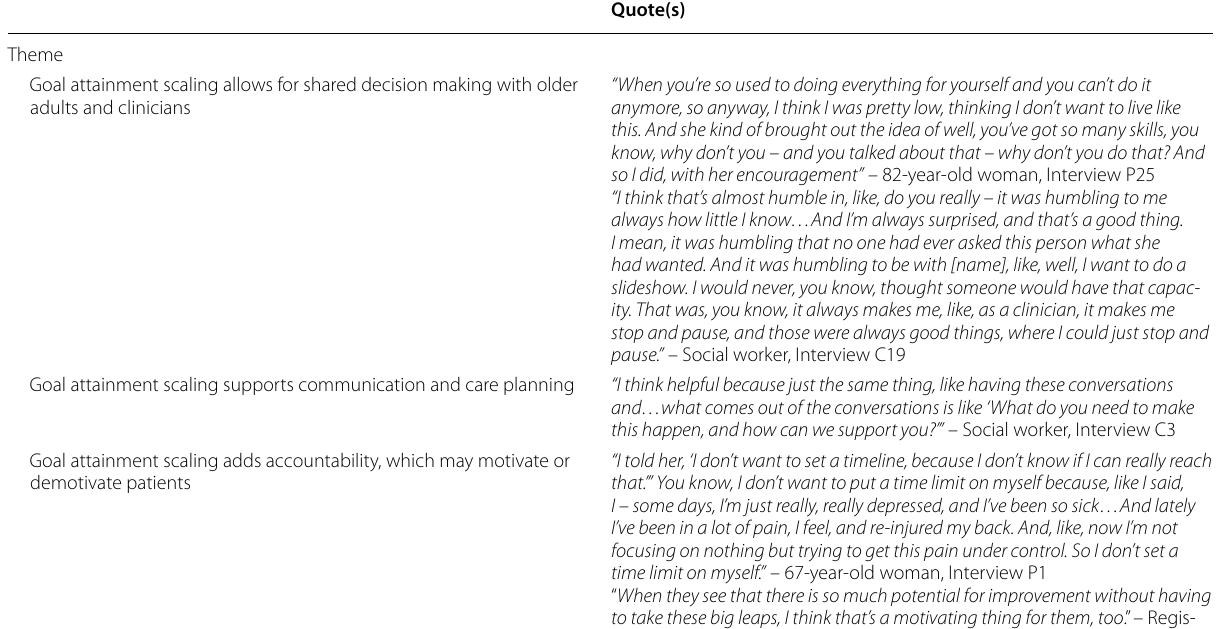
Table 3 Themes from interviews with older adults and clinicians using goal attainment scaling Theme Goal attainment scaling allows for shared decision making with older adults and